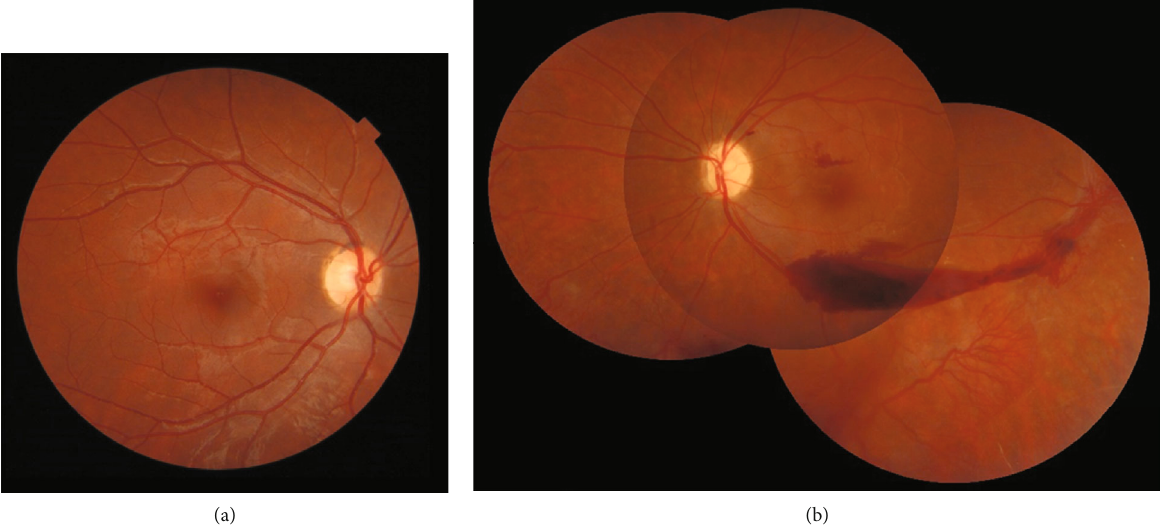
Figure 1: Fundus photograph of the right eye (a) revealed normal fundus appearance. Montage fundus photograph of the left eye (b) revealed vitreous hemorrhage, moderately pale optic disc, macular hemorrhage, extensive peripheral retinal avascular area, sea fan neovascularization, and small fi brotic tissue in the temporal midperipheral retina.